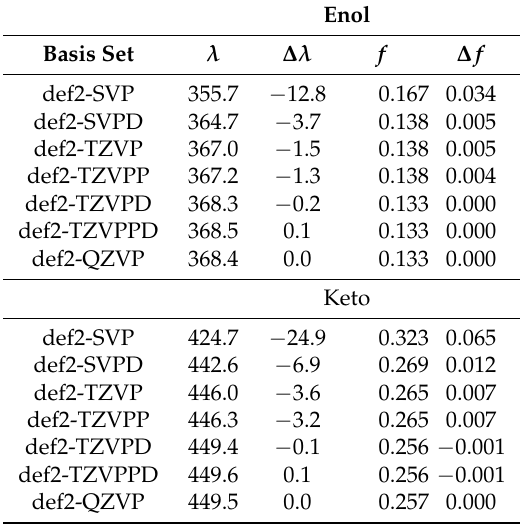
Table 5. RI-CC2 first wavelength of excitation ( λ , in nm) and oscillator strength ( f ), and their variations ( ∆ λ and ∆ f ) with respect to def2-QZVP for the isolated PYV3 · I2but [PYV3 · I2but] heteromer as a function of the basis set. All calculations were performed at the RI-CC2 level of approximation.